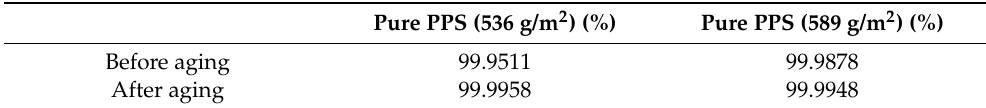
Table 4. Filtration efficiency of different grams of PPS filter